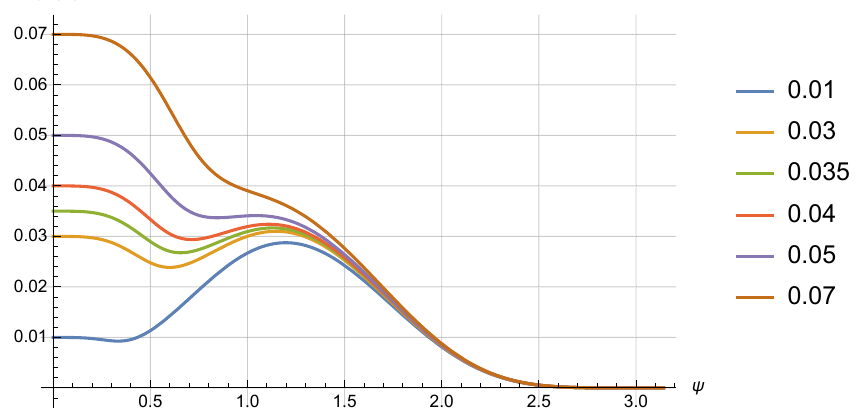
Figure 2 . A plot of the extremal potential V depict the plot for different values of the p/ ˜ M (the values of p/ ˜ M for each color are quoted in the legend on the